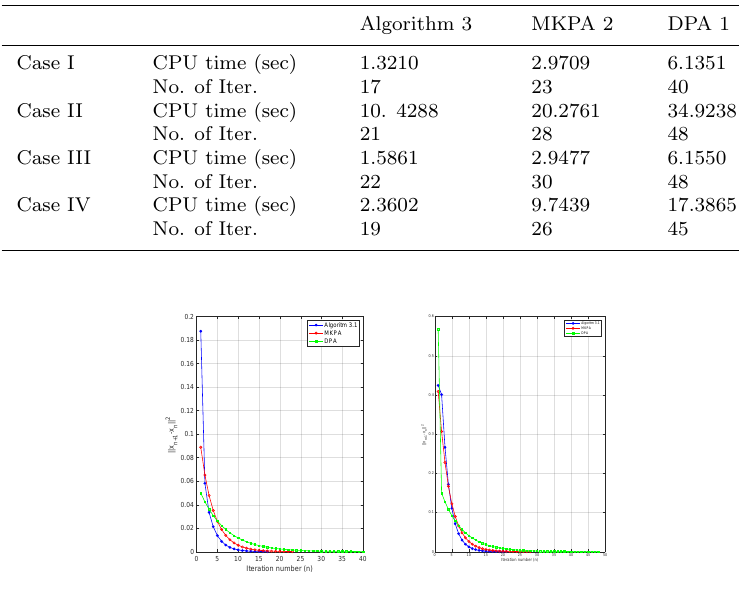
Figure 3. Example 2. Left: Case I; Right: Case II.